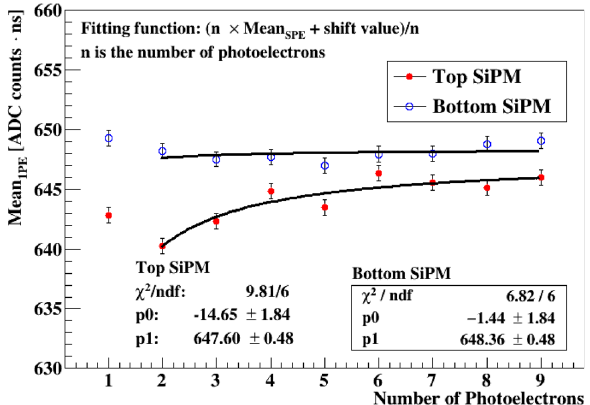
Fig. 7 Mean 1PE distributions obtained from top and bottom SiPMs